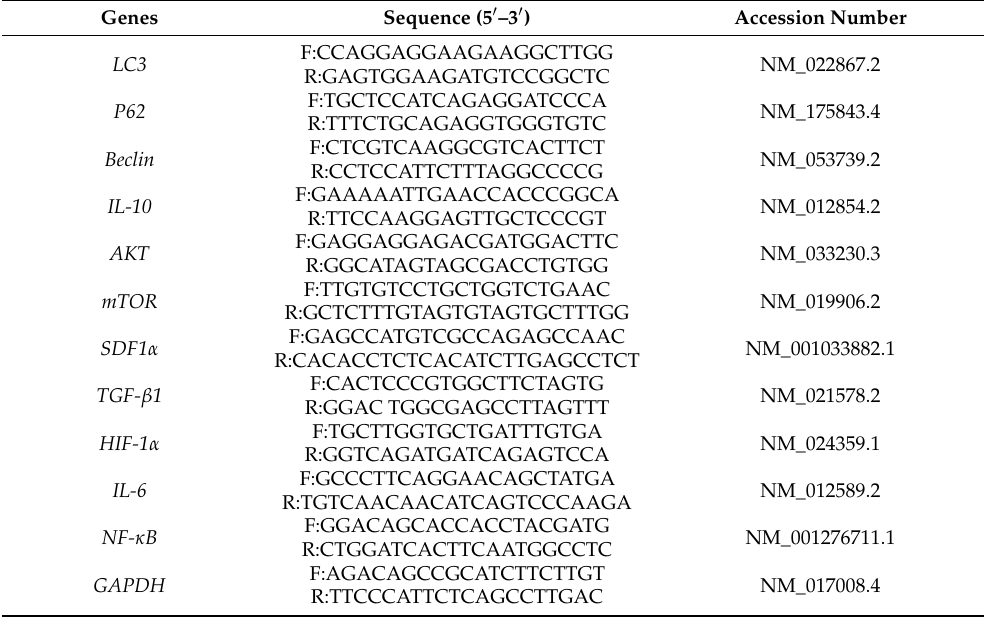
Table 1. Primers sequences for Real-Time